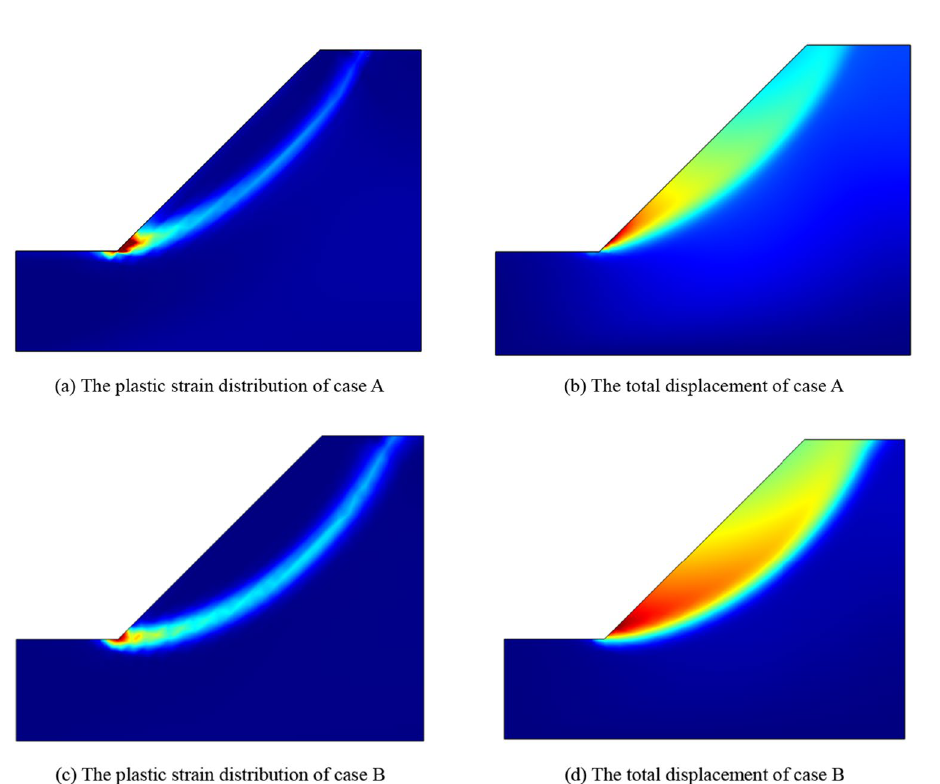
Figure 9. The plastic strain distribution and total